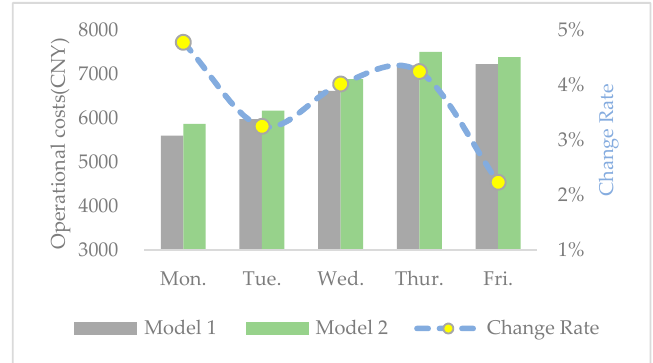
Figure 6. Carbon emissions and change rate in the two models.